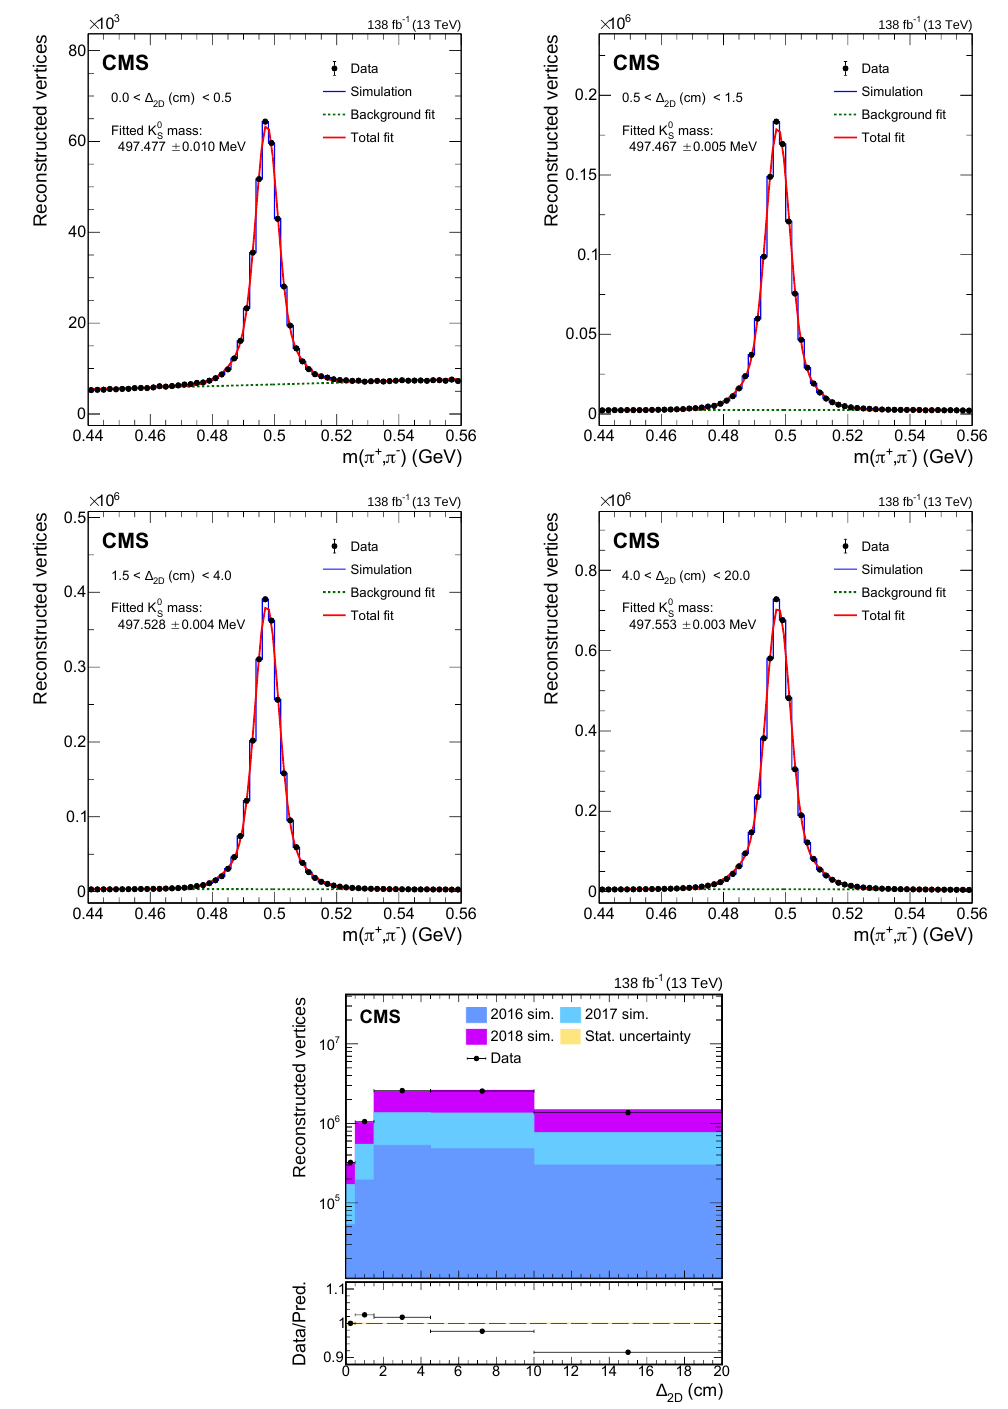
candidates reconstructed using the p ± p ∓ S candidate mass in data in each region is also S candidate yield after subtracting the background in data S vertex to the PV. S